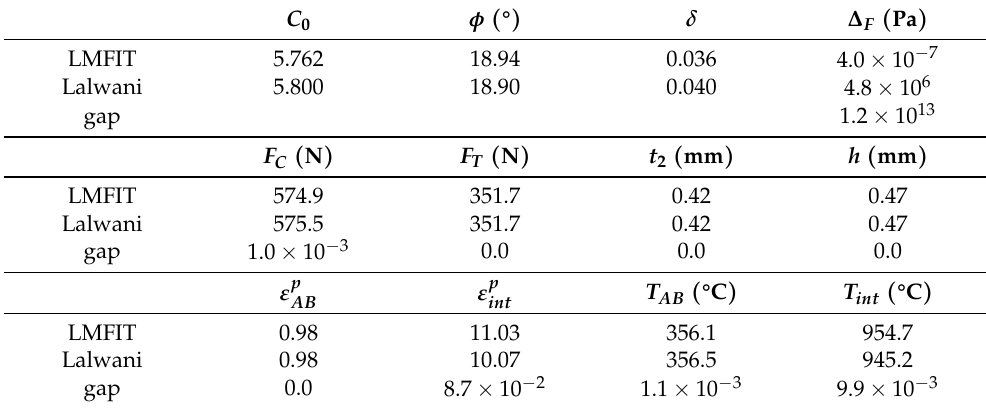
Table 2. Results for orthogonal machining of AISI 1045 at V = 200 m/min, t 1 = 0.15 mm, α = and w = 1.6